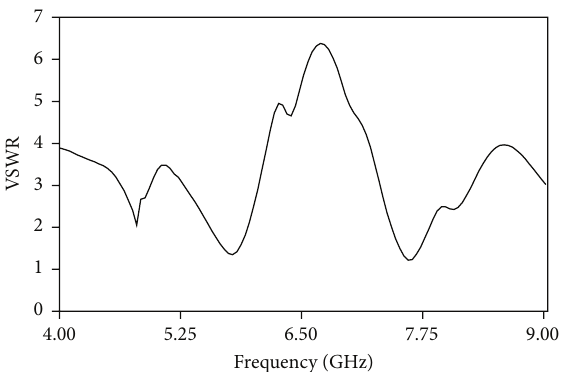
Figure 11: VSWR of the proposed microstrip antenna.